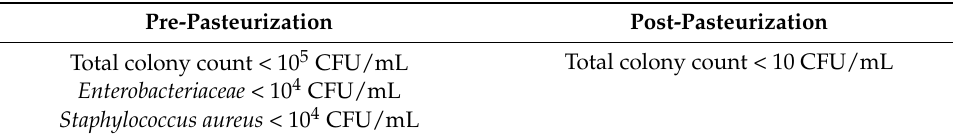
Table 1. Israeli Ministry of Health guidelines for microbial limits of donor human milk, in milk bank operation